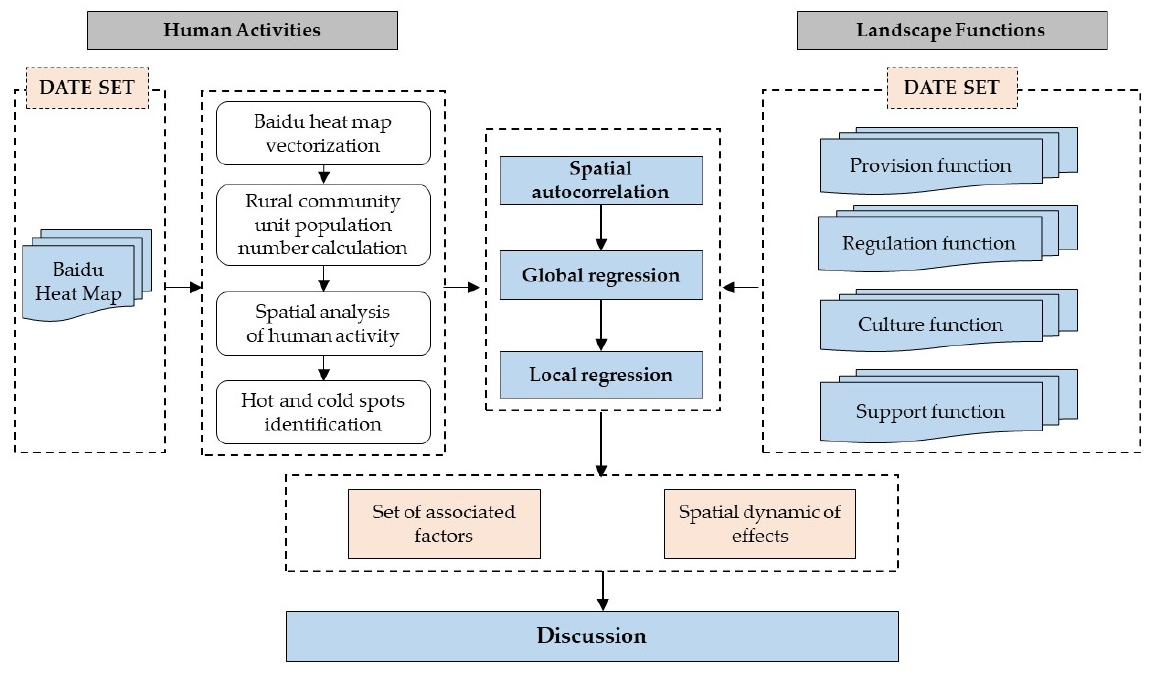
Figure 4. The flowchart of the research process.